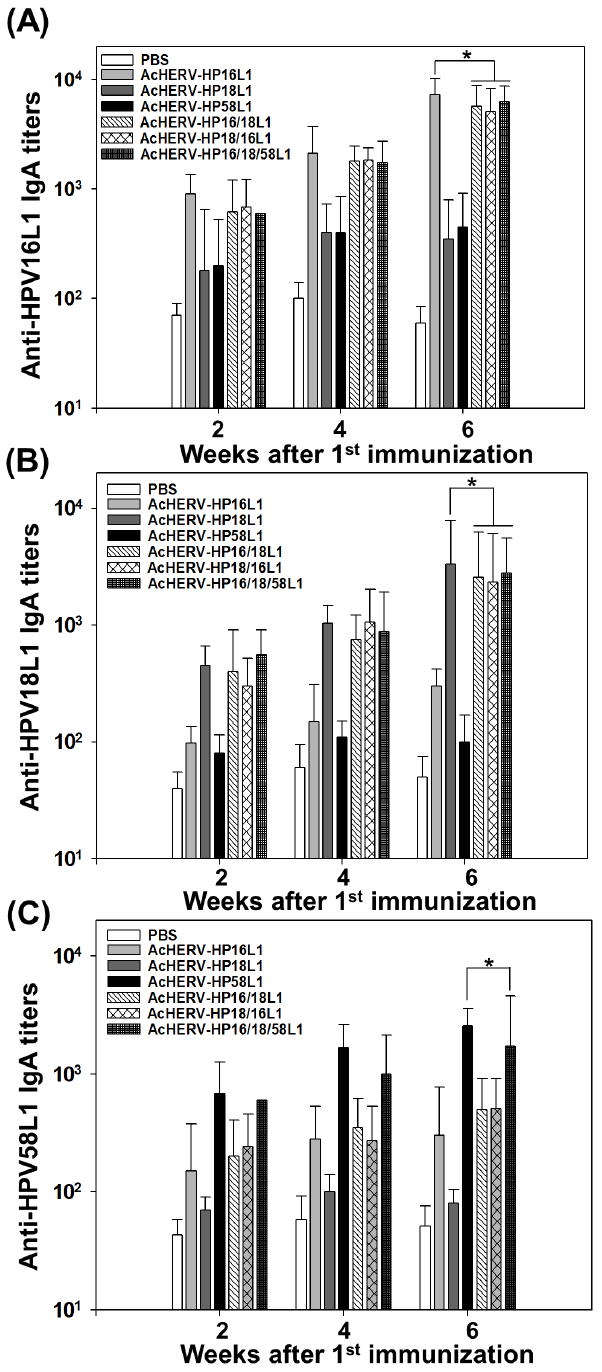
Figure 5. Induction of HPV type-specific L1s IgA antibodies in vaginal washes. BALB/c mice were intramuscularly injected with PBS or 1 6 10 7 PFU of AcHERV-based nanovaccines. Antigen specific IgA antibodiy titers against HPV 16L1 (A) or HPV 18L1 (B) or HPV 58L1 (C) in murine vaginal washes were determined by ELISA. * p , 0.05 (ANOVA and Student-Newman-Keuls test): Bivalent and trivalent groups were compared with each monovalent group.